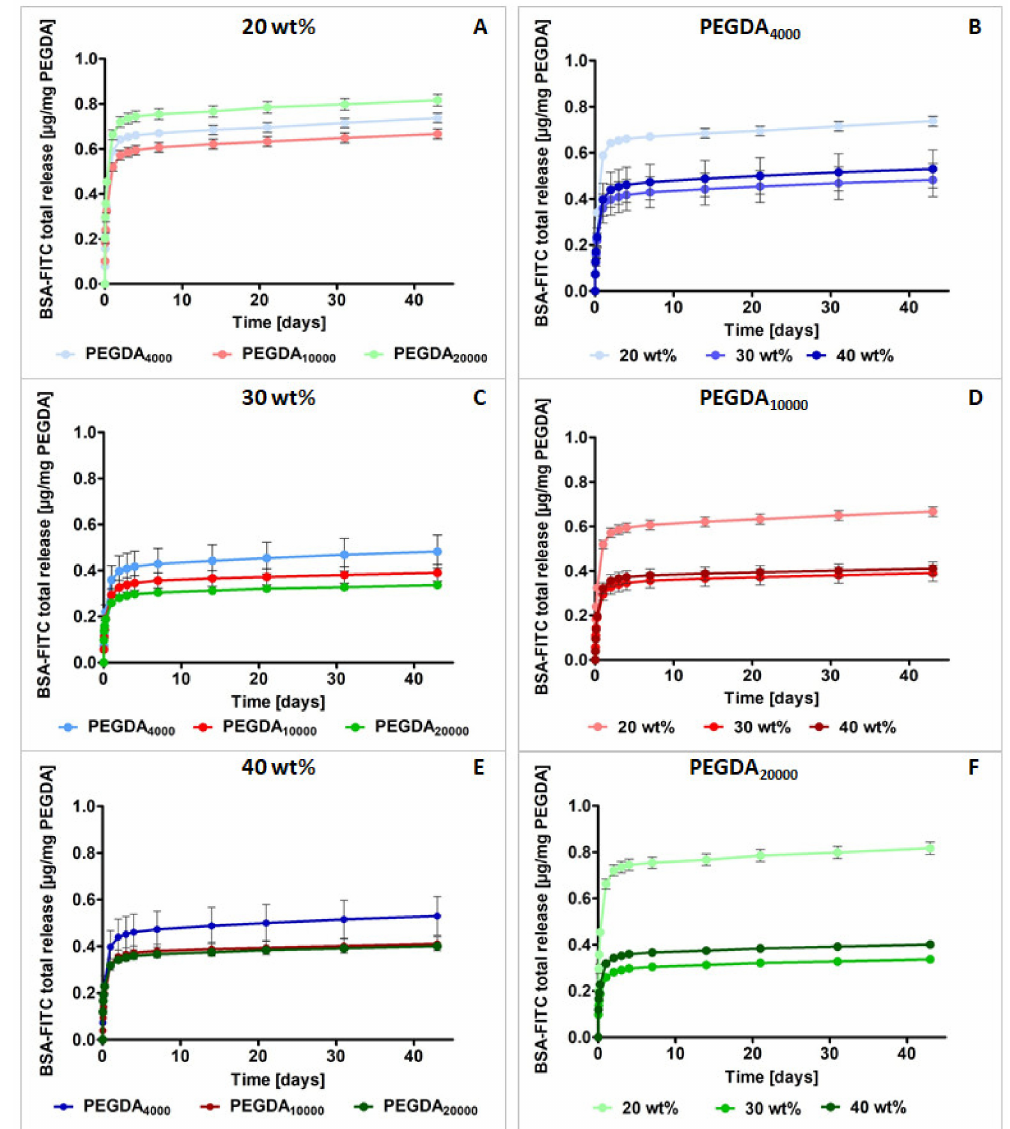
Figure 7. Total quantitative release of BSA–FITC within 43 days normalized to 1 mg PEGDA in mean ± SD. ( left ) Different PEGDA concentrations: ( A ) 20 wt %; ( C ) 30 wt %; ( E ) 40 wt %. ( right ) PEGDAs with different molecular mass: ( B ) PEGDA 4000 g/mol; ( D ) PEGDA 10,000 g/mol; ( F ) PEGDA 20,000 g/mol. Each sample contained 0.075 wt % of BSA–FITC (referring to PEGDA